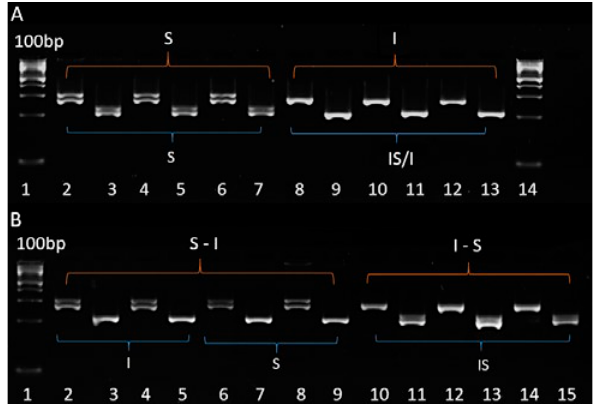
Figure 2. Segregation of mefenoxam sensitive and intermediately sensitive/insensitive Phytophthora capsici isolates, based on the SSR markers PCSSR19 and PCN3. S = sensitive, IS = intermediately sen- sitive, I = insensitive. Predictions based on the markers are shown above the fragments, and mefenoxam sensitivities of the isolates are shown below the fragments. Fragment sizes for each primer pair are as follows: PCSSR19 (S, 263 bp, 281 bp and 325 bp; IS/I, 252 bp and 270 bp) , PCN3 (S, 240-250 bp and 205-215 bp; IS/I, 205- 215 bp). (A) Isolates showing the same segregation pattern for both PCSSR19 and PCN3. Lanes 1 and 14 are the 100 bp ladder. Even numbered lanes 2 to 12 are marker PCSSR19, odd numbered lanes 3 to 13 are PCN3. (B) Isolates exhibiting different segregation pat- terns with the markers PCSSR19 and PCN3. Lane 1, 100 bp ladder, even numbered lanes 2 to 14, PCSSR19, odd numbered lanes 3 to 15,